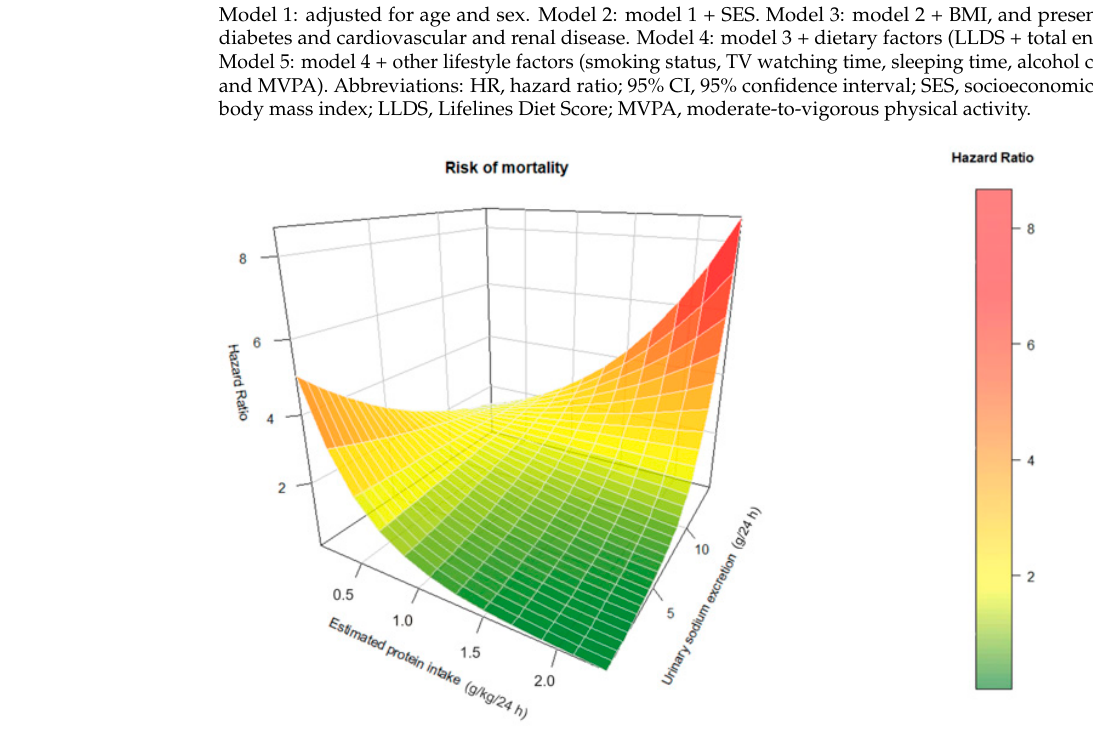
Figure 2. Three-dimensional graph of the combined effect of sodium intake and protein intake calculated by the Maroni formula with all-cause mortality. Table 3. Associations between sodium intake, protein intake, and their interaction term with all- cause mortality.